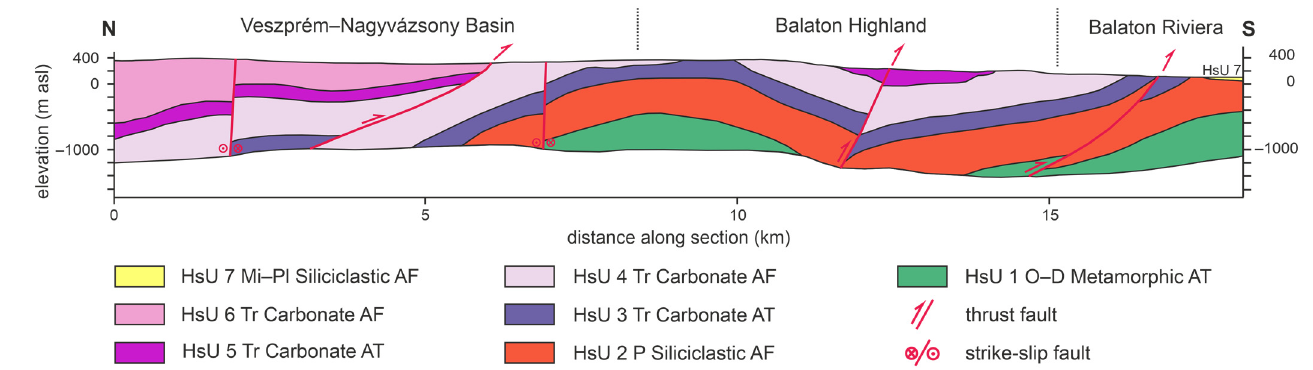
Figure 3. Hydrostratigraphic cross-section of the Balaton Highland (see the track in Figure 1) (after Budai et al. [28].)